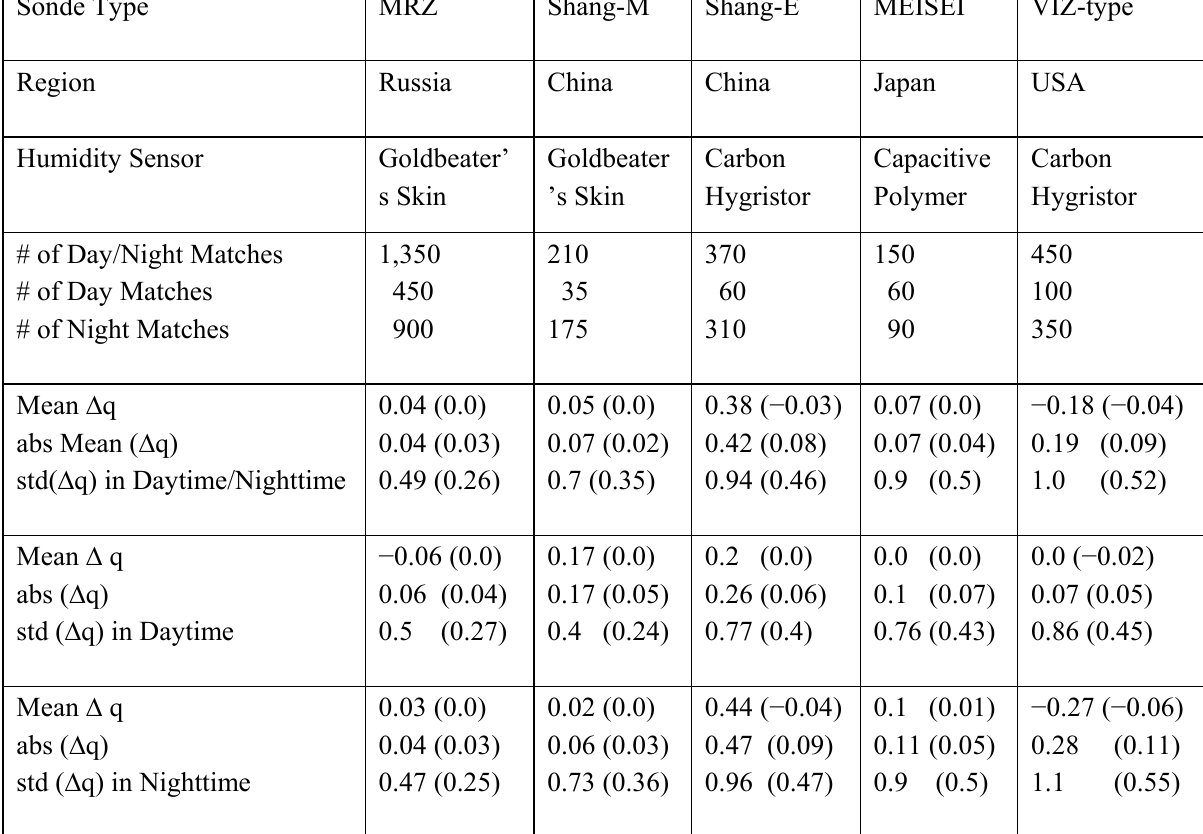
Table 1. Summary of the mean specific humidity ( q ) difference ( ∆ q) , absolute mean difference (abs Mean ∆ q) , and standard deviation (std ( ∆ q) ) of specific humidity of the COSMIC-radiosonde pairs and COSMIC-ECMWF pairs for MRZ, Shang/M, Shang/E, MEISEI, and VIZ-type. Numbers of COSMIC-radiosonde pairs at 8 km is used here and are listed as # of matches. The unit of q is g/kg. ∆ q at all available levels are from 0.5 km to 8 km. The mean ∆ q for COSMIC-radiosonde pairs and COSMIC-ECMWF pairs are defined as COSMIC minus radiosonde specific humidity and COSMIC minus ECMWF specific humidity, respectively. The Mean ∆ q, abs Mean ( ∆ q), and std( ∆ q) of COSMIC-ECMWF pairs are shown in the